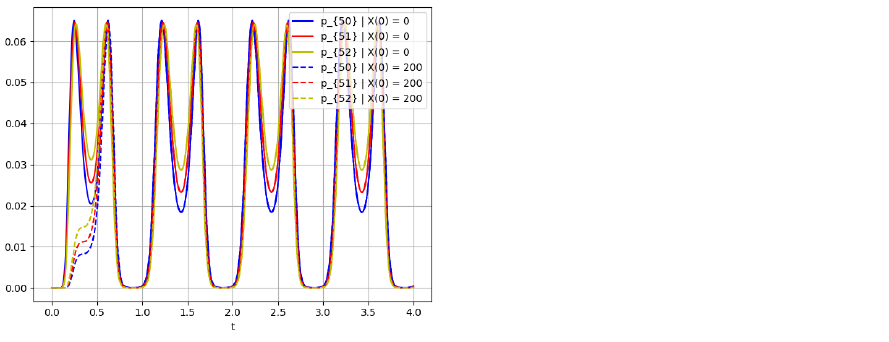
Figure 11. Probability p 50 ( t ) , p 51 ( t ) , p 52 ( t ) for t ∈ [ 0,4 ] ; this figure shows the rate of convergence.